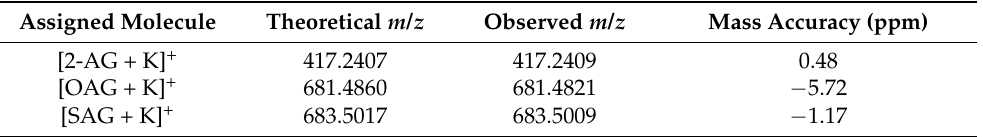
Table 1. m/z accuracy of targeted molecules from standard 2-AG and mice brain tissues. Assigned